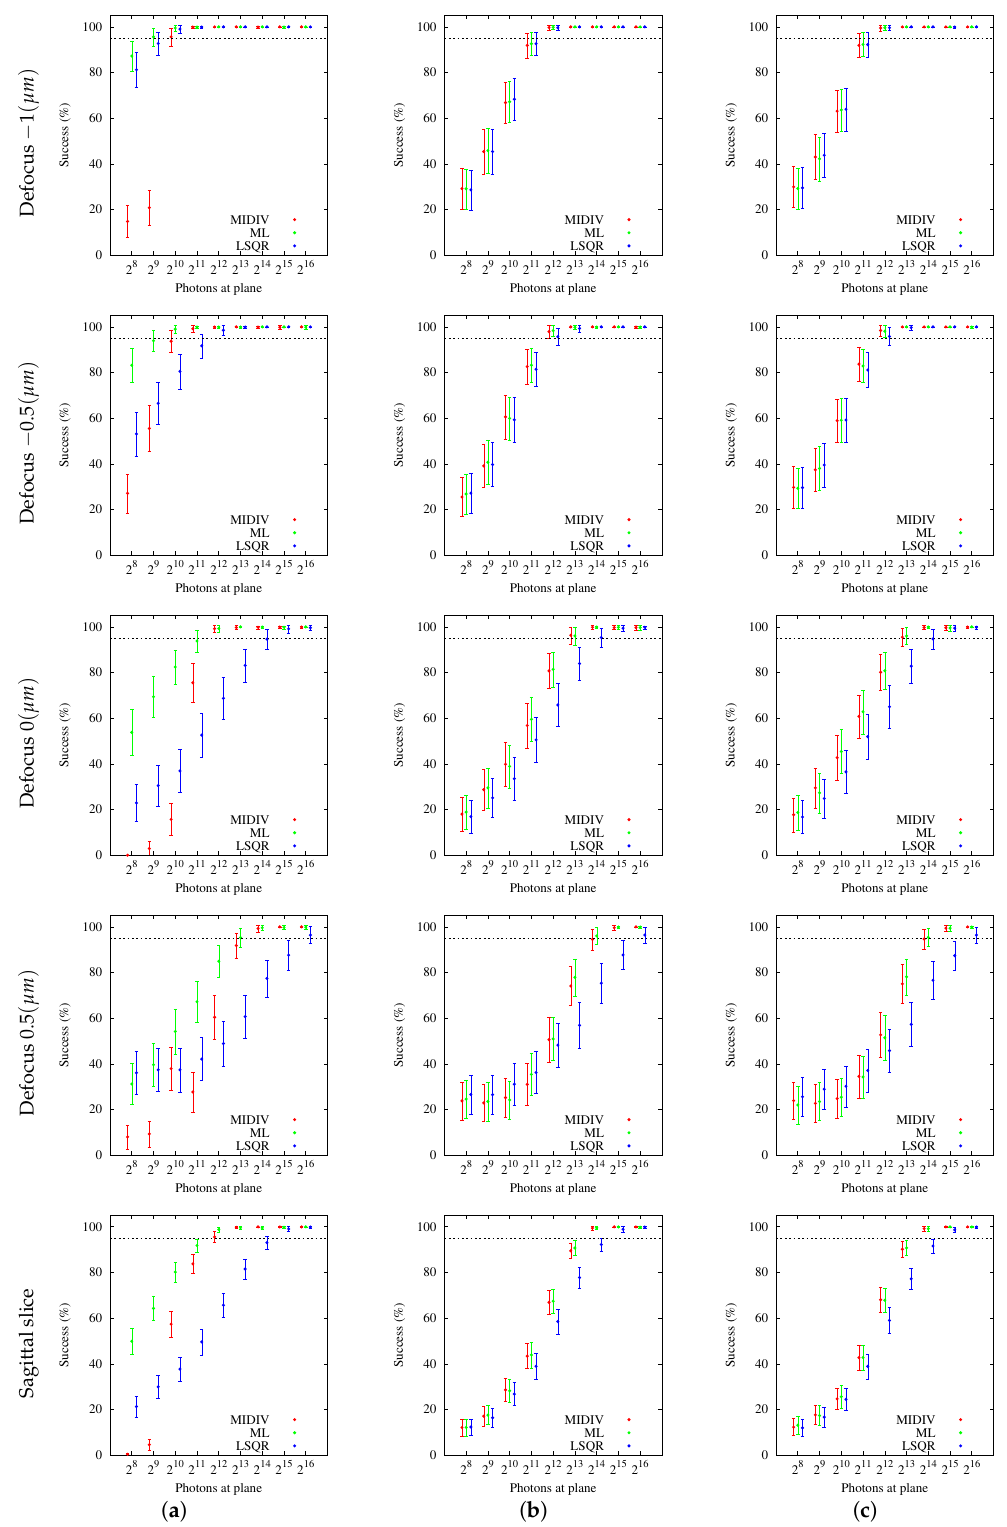
Figure 5. Success measurements of the methods: MIDIV (red), ML (green) and LSQR (blue). A dashed line at 95% has been plotted in all subfigures for reference. Estimation results are presented as the mean point estimates of the success percentages and their confidence intervals. ( a ) NCI; ( b ) NCII; ( c )